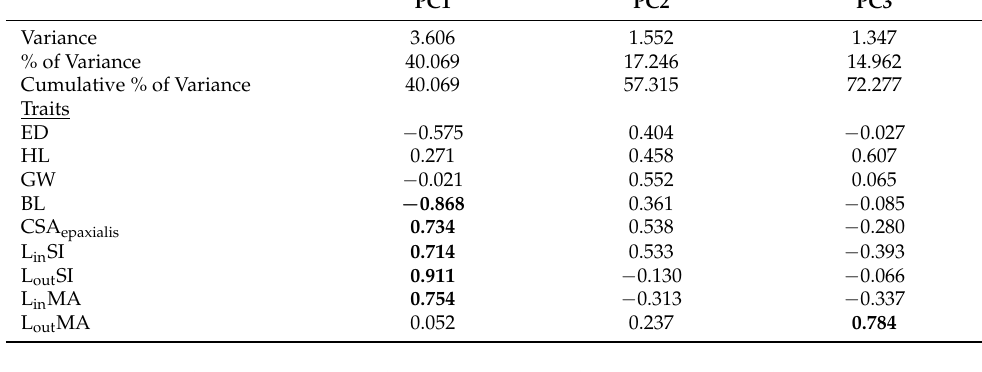
Table 4. Coefficients of the 9 traits selected to describe differences in the feeding apparatus of six species of the genus Trematomus as resulting from the PCA after standardization by SL. In each component, highest and lowest (relative of driving variables) coefficients are in bold.